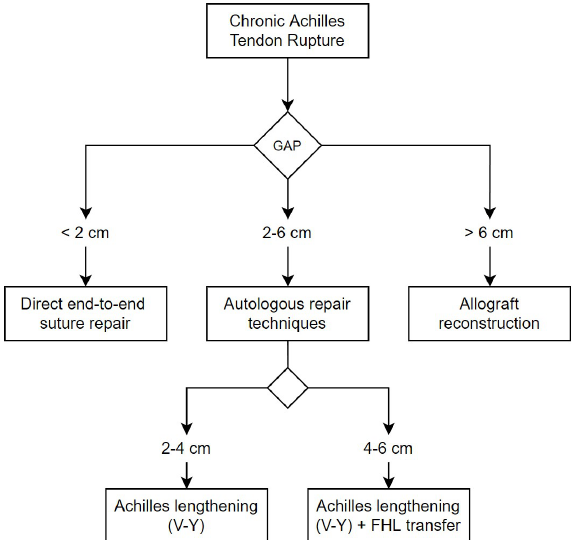
Figure 1. Our surgical algorithm for chronic Achilles tendon rupture, based on gap size. Lesser than 2 cm a direct end-to-end suture was performed. Between 2 cm and 6 cm, autologous techniques were used. If the gap was greater than 6 cm, reconstruction was done using an Achilles tendon allograft with calcaneal bone block.